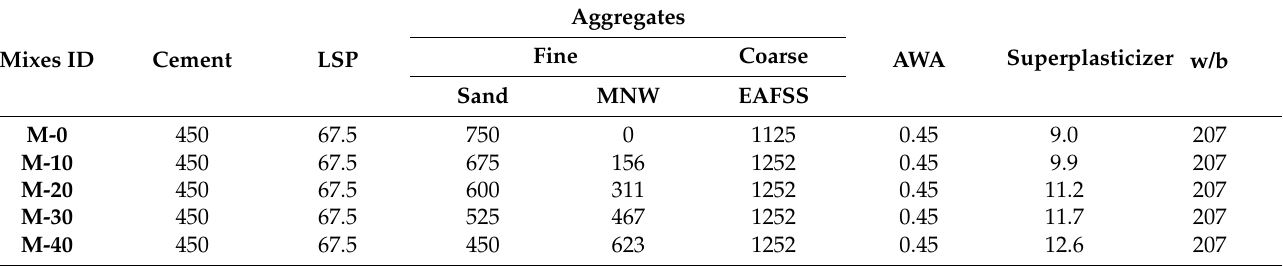
Table 2. Concrete mixtures proportions (kg/m 3